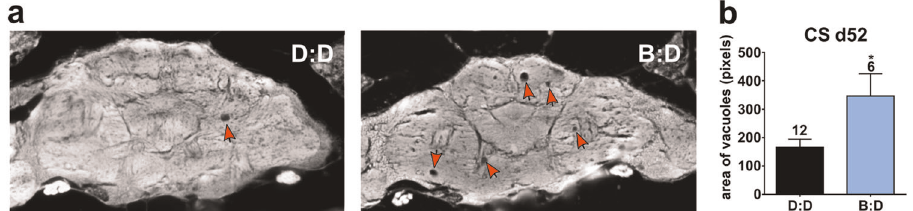
Fig. 4 Blue-light exposure leads to neurodegeneration in the aging fl y brain. a Representative brain sections showing brain vacuoles (red arrows) in 52-day-old CS males in D:D compared with B:D. b Average area of vacuoles is signi fi cantly higher in B:D (unpaired t test, p = 0.0165). Numbers above bars indicate the sample size in each light condition. Error bars show